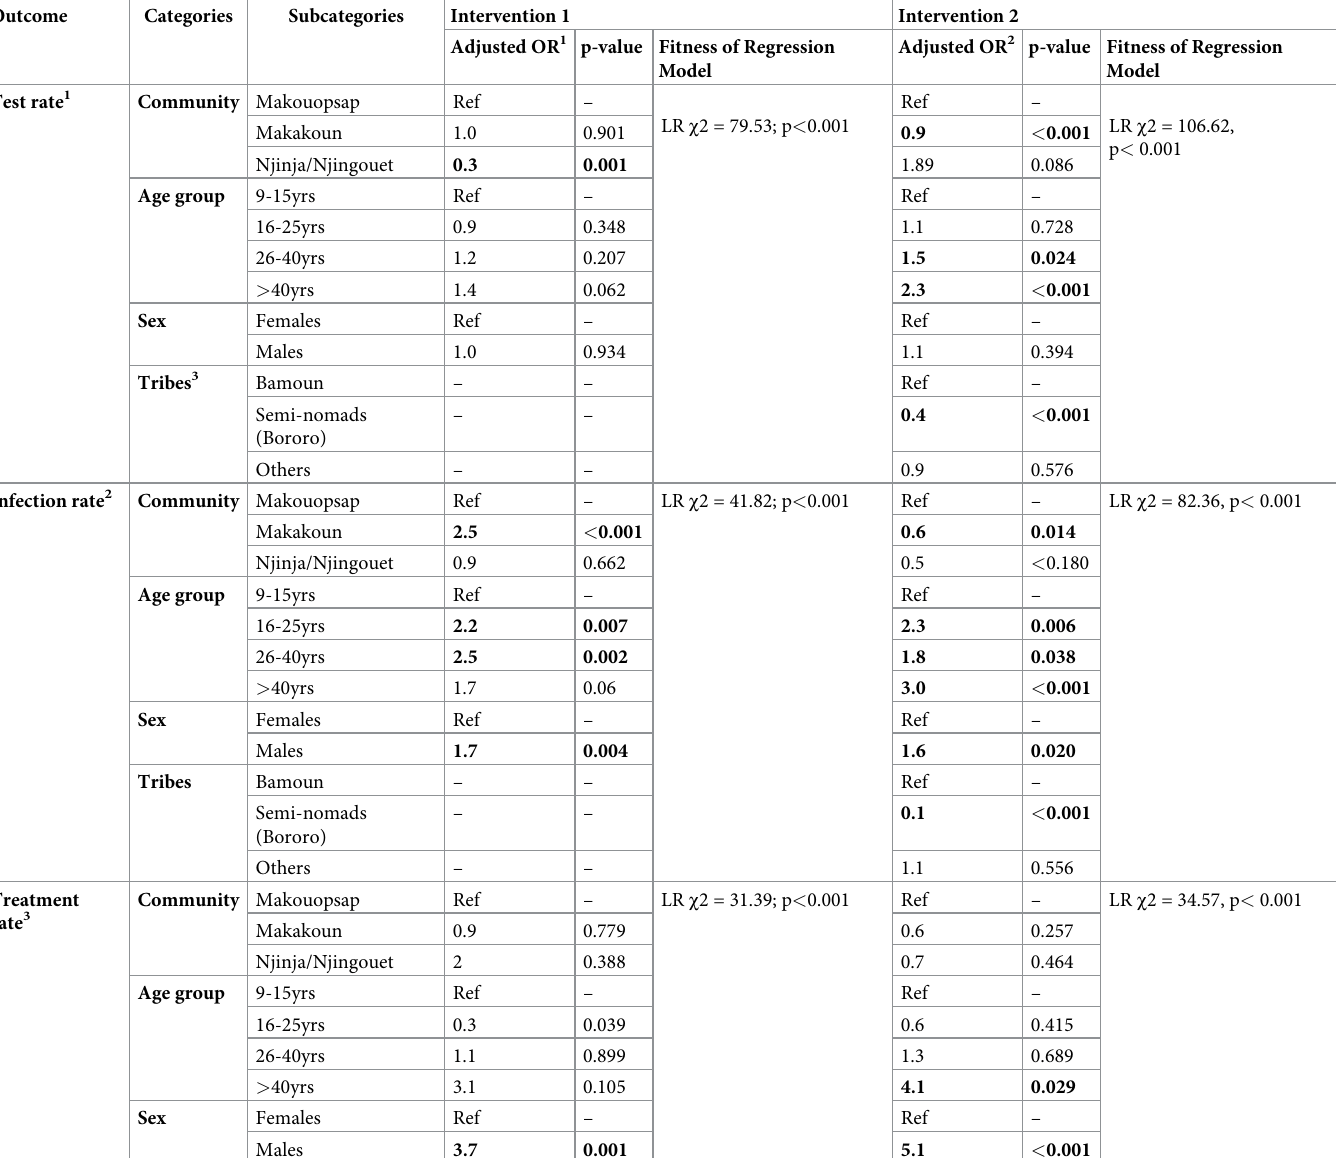
Table 3. Intervention 1 and 2 test, infection and treatment rates comparison within